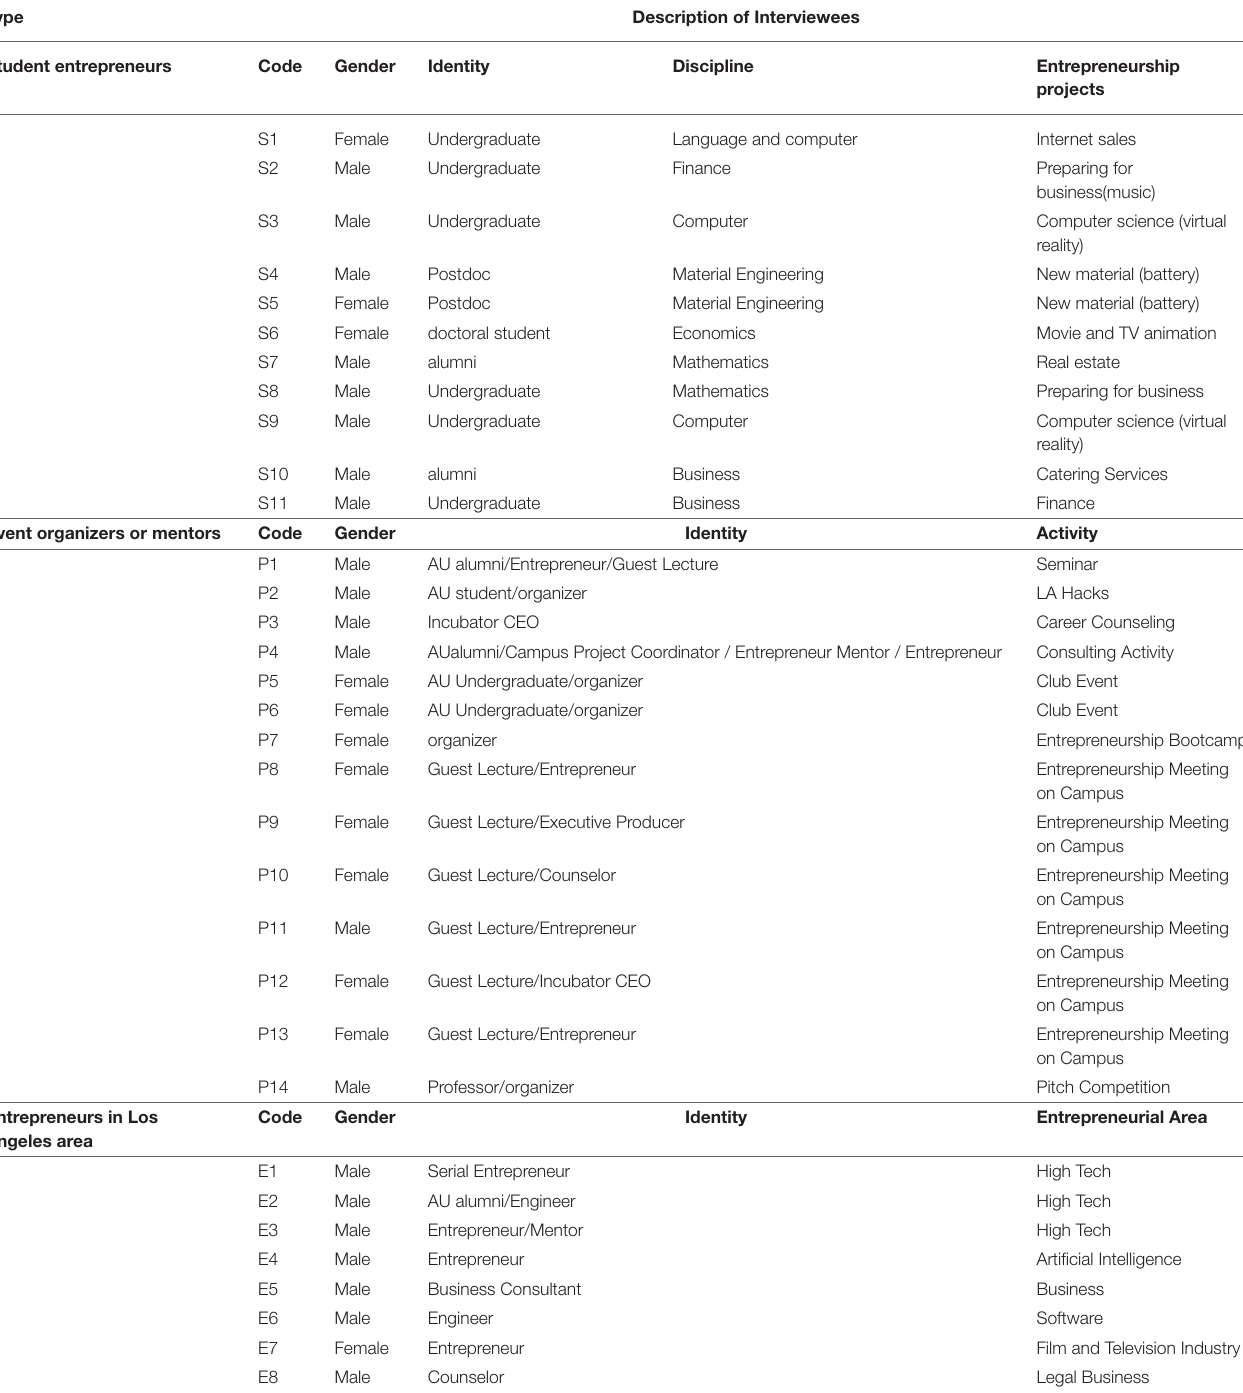
TABLE 1 | Code list of interviewees.